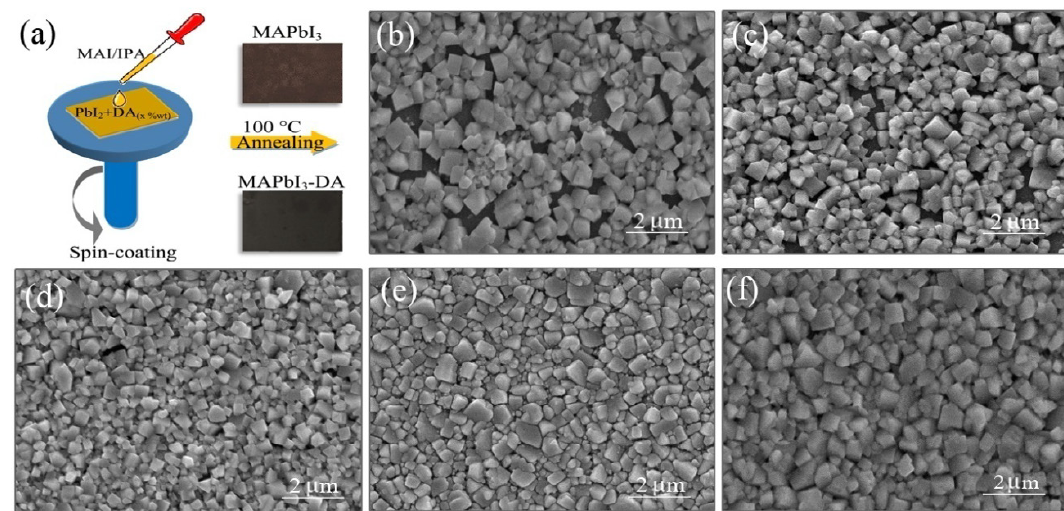
Fig. 2. (a) Schematic of preparation of MAPbI 3 by spin-coating MAI solution on PbI 2 film with DA additive. Surface SEM images of perovskite films with various concentration of DA in PbI 2 precursor (a) without DA; (b) 0.2 wt% DA; (c) 0.4 wt% DA; (d) 0.6 wt% DA and (e) 0.8 wt% DA .